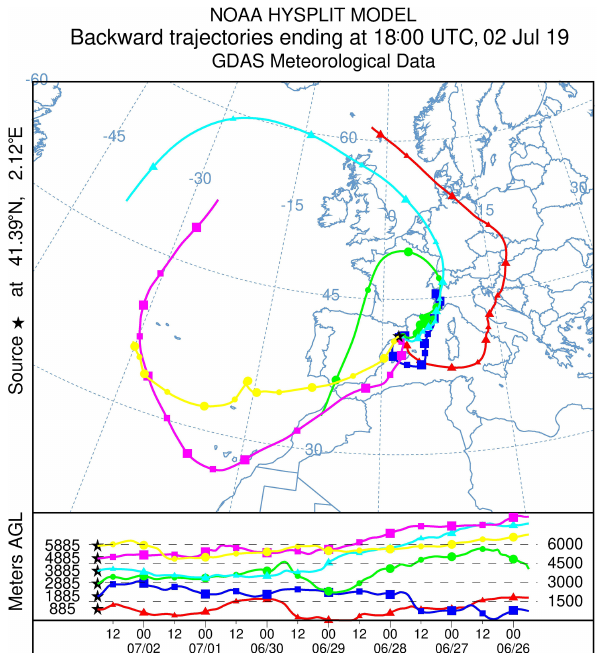
Figure 11. HYSPLIT model back trajectories for the air masses between 0.9 and 5.9kma.g.l. (equivalent to 1 and 6kma.s.l., re- spectively) over Barcelona at 18:00UTC on 2 July